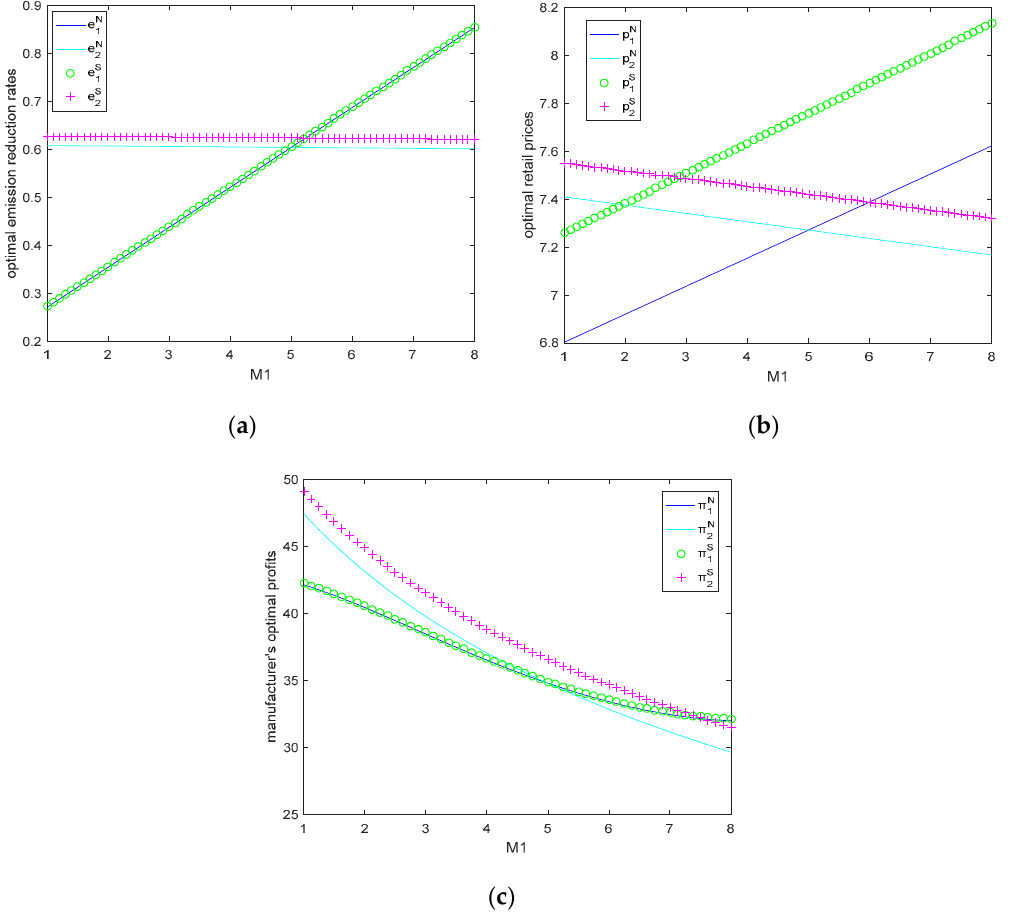
Figure 5. ( a ) Optimal emission reduction rates, ( b ) optimal retail prices, and ( c ) manufacturer’s profits as a function of M1.